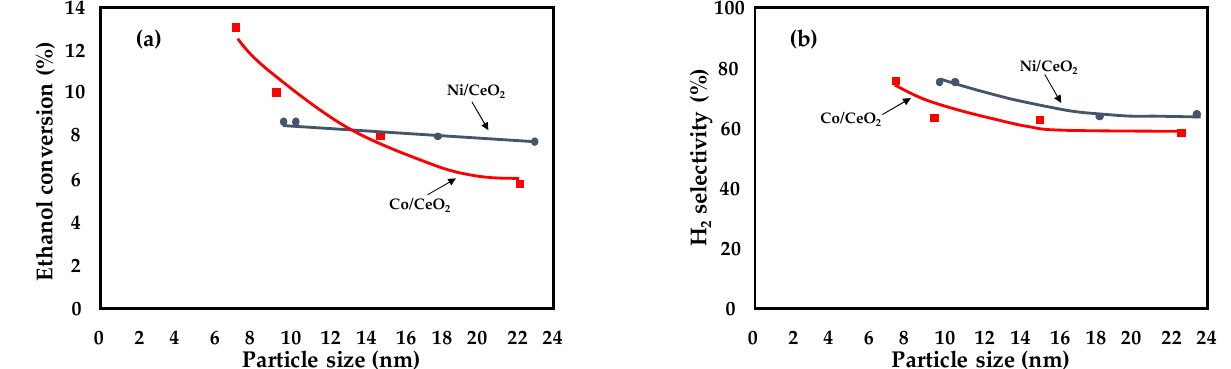
Figure 3. Catalytic performance of Co- and Ni-supported CeO 2 samples as a function of the metal particle size. Adapted from [27]; T = 420 ◦ C; P = 1 atm; H 2 O/C 2 H 5 OH = 12; GHSV = 1,286,000 mL · g − 1 h − 1 . ( a ) ethanol conversion and ( b ) H 2 selectivity vs metals particle